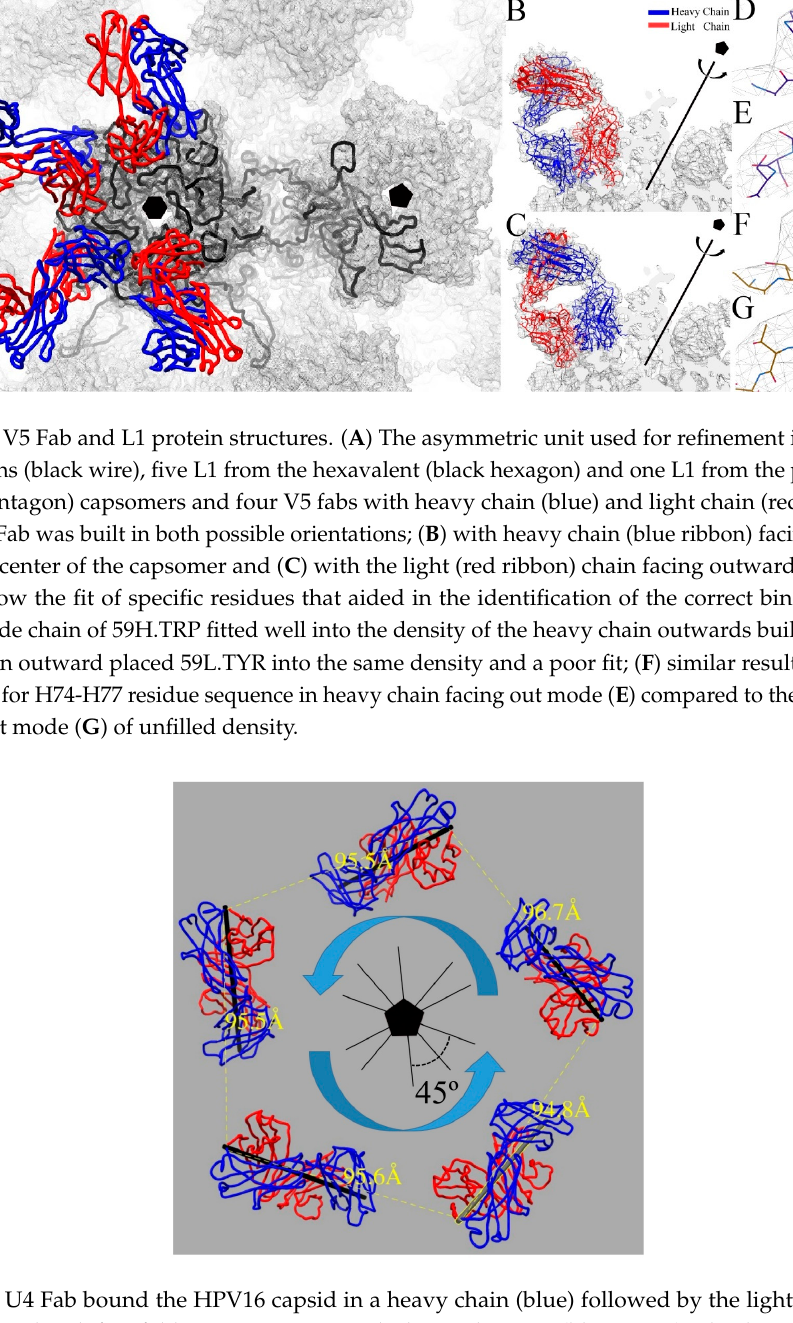
The structure of U4 Fab was produced using the same method as for V5. The L1 asymmetric unit structure produced from the HPV-V5 complex was used to initiate building L1 in the HPV-U4 complex. Since U4 Fab only bound in the canyon around the pentavalent capsomers, the asymmetric unit for HPV-U4 included six L1 proteins and one U4 Fab. This unit was used to generate the whole capsid-U4 structure for Phenix global refinement. U4 Fab was built with the heavy chain relative to the light chain (heavy chain followed by the light chain) around the five-fold vertex in a counterclockwise direction (Figure 4) [12]. The Molprobity score was also used to evaluate U4 model building (Table 3).